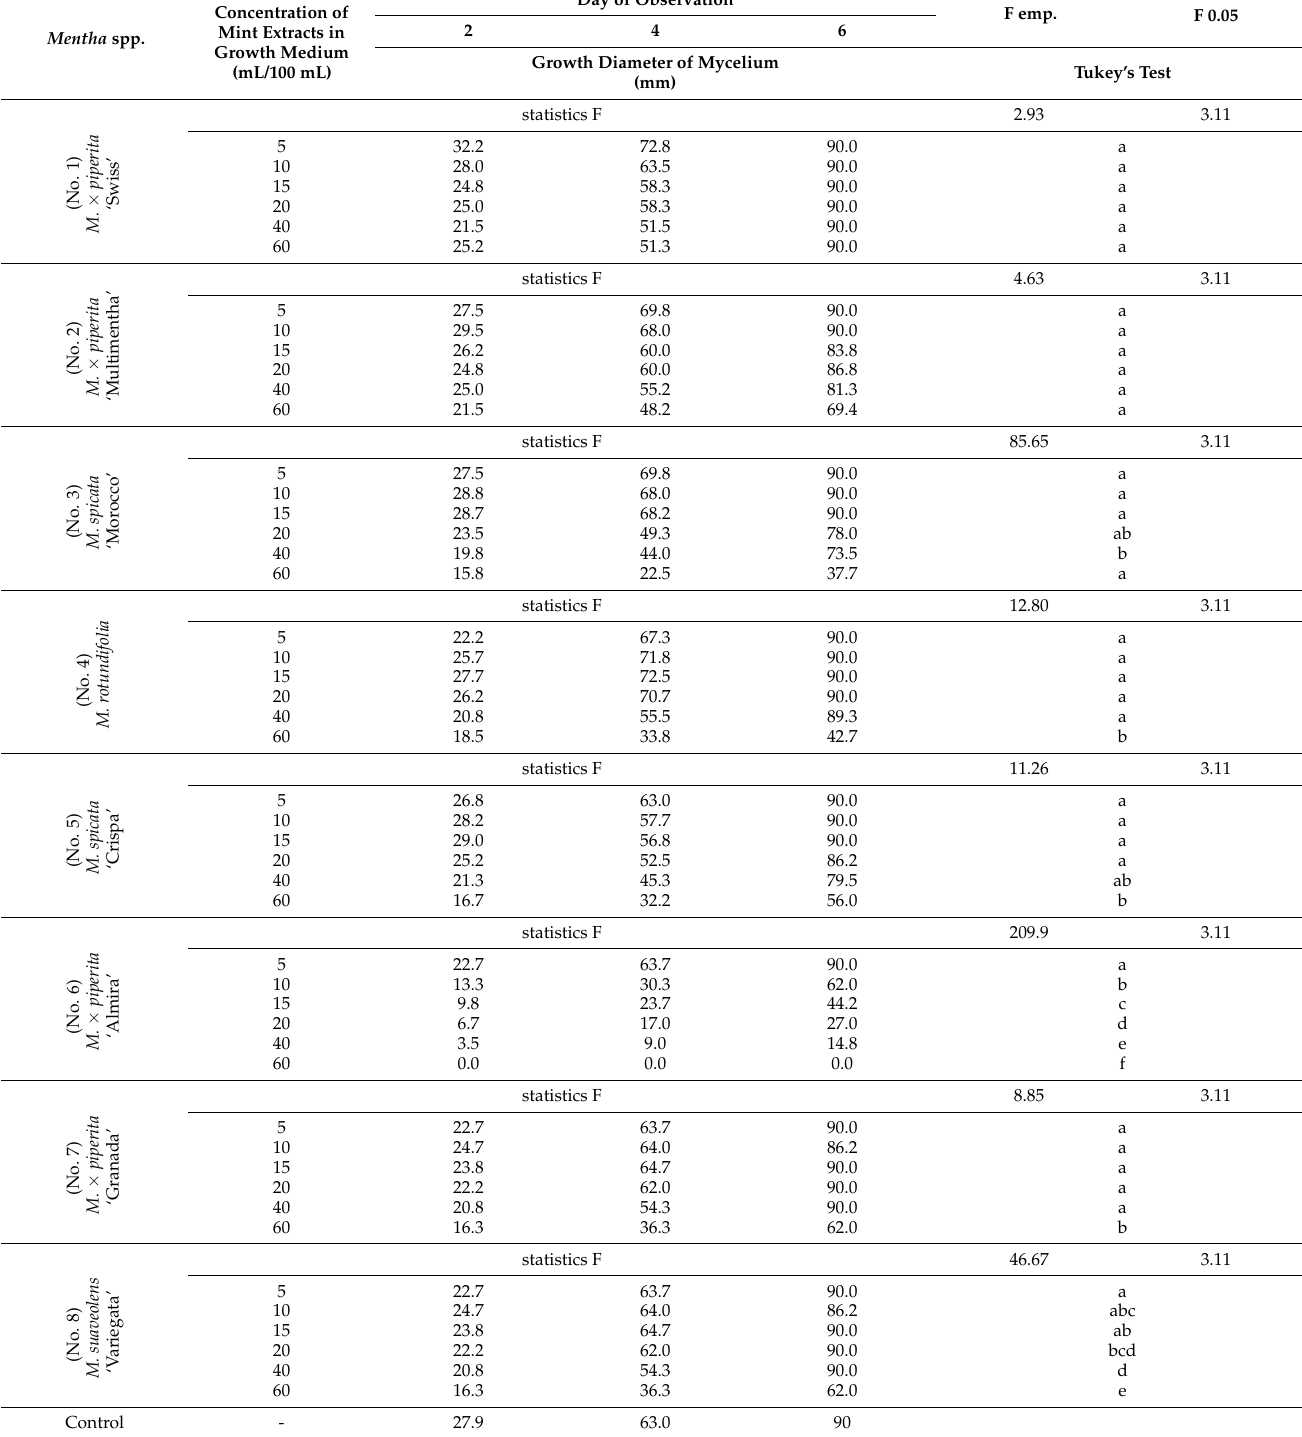
Table 2. Growth diameter of Ch. globosum on a medium containing various amounts of mint extracts.